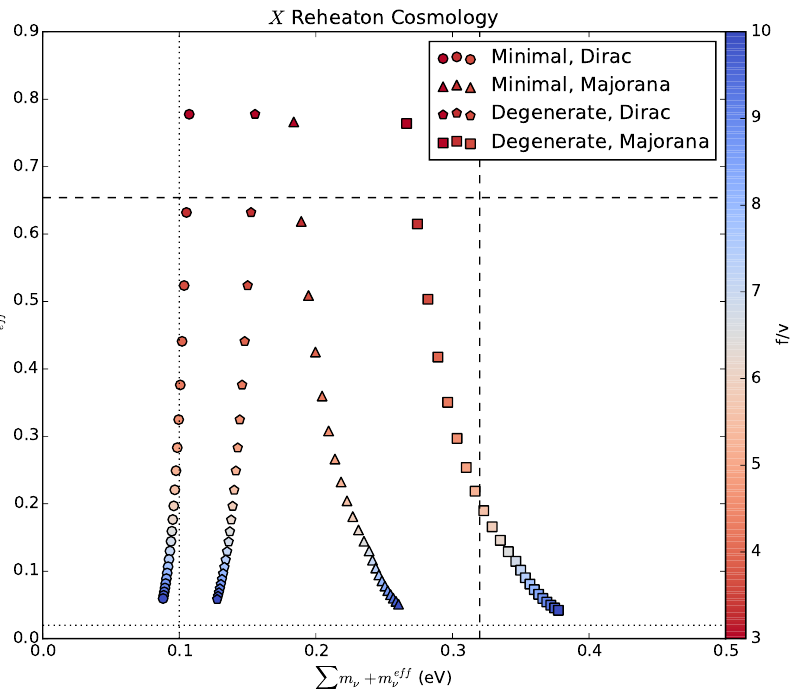
Figure 9 . Predicted values of (cid:1) N e(cid:11) and P m (cid:23) + m e(cid:11) for minimal and degenerate neutrino mass (cid:23) spectra with both Dirac and Majorana masses for f=v from 3 to 10. The Planck 2015 [2] bounds on P m (cid:23) and N e(cid:11) , as discussed in section 3.3.3, are represented by the dashed lines, and the projected CMB-S4 constraints are given by the dotted lines. It has been assumed that (cid:0) t (cid:24) ( v=f ) 2 . (cid:0) SM Note however, that, from (cid:12)gure 8, this scaling of the partial widths holds only for the mass range 50 GeV . m X . 120 GeV, outside of which the twin partial width is more suppressed and the model is only testable through (cid:1) N e(cid:11) over a smaller range in f=v